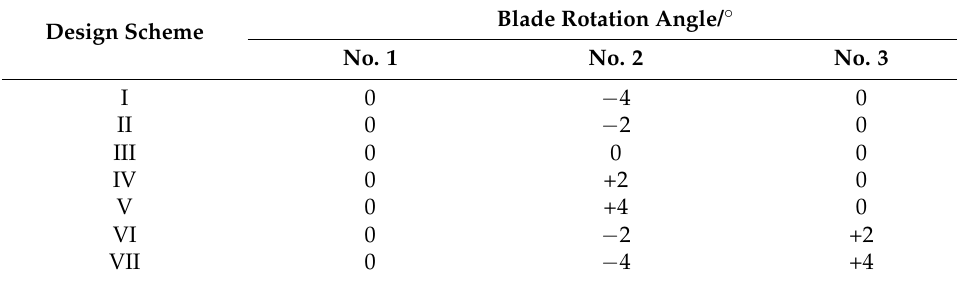
Figure 4. ( a ) BRADs indication; and ( b ) blade number. Table 1. Design Scheme settings. Table 1. Design Scheme